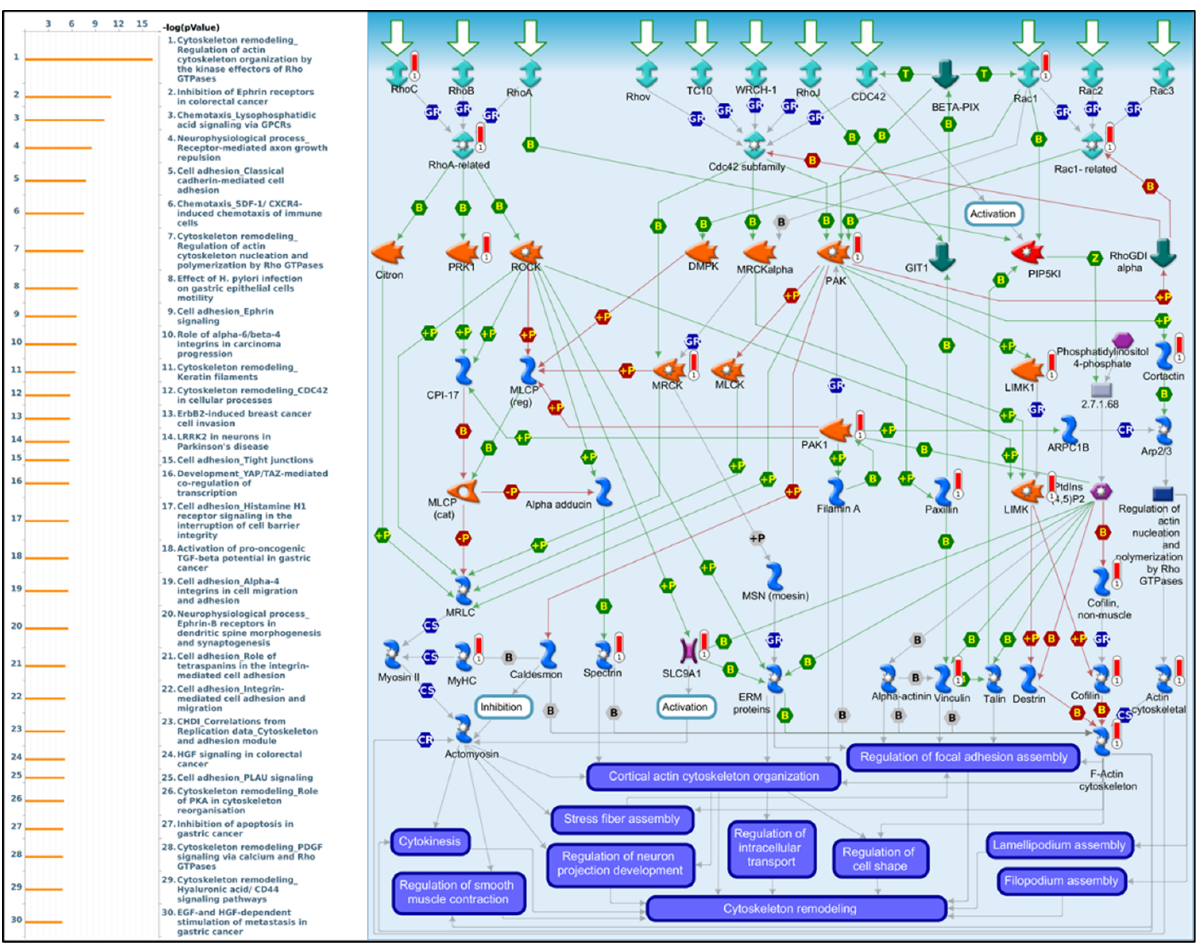
Figure 9. MetaCore pathway analysis of the co-expression gene network of oxysterol-binding protein-like 3 (OSBPL3) in pancreatic cancer patients. Downstream pathway analyses revealed that “Cytoskeleton remodeling_Regulation of actin cytoskeleton organization by the kinase effectors of Rho GTPases” might play an important role in pancreatic cancer development.